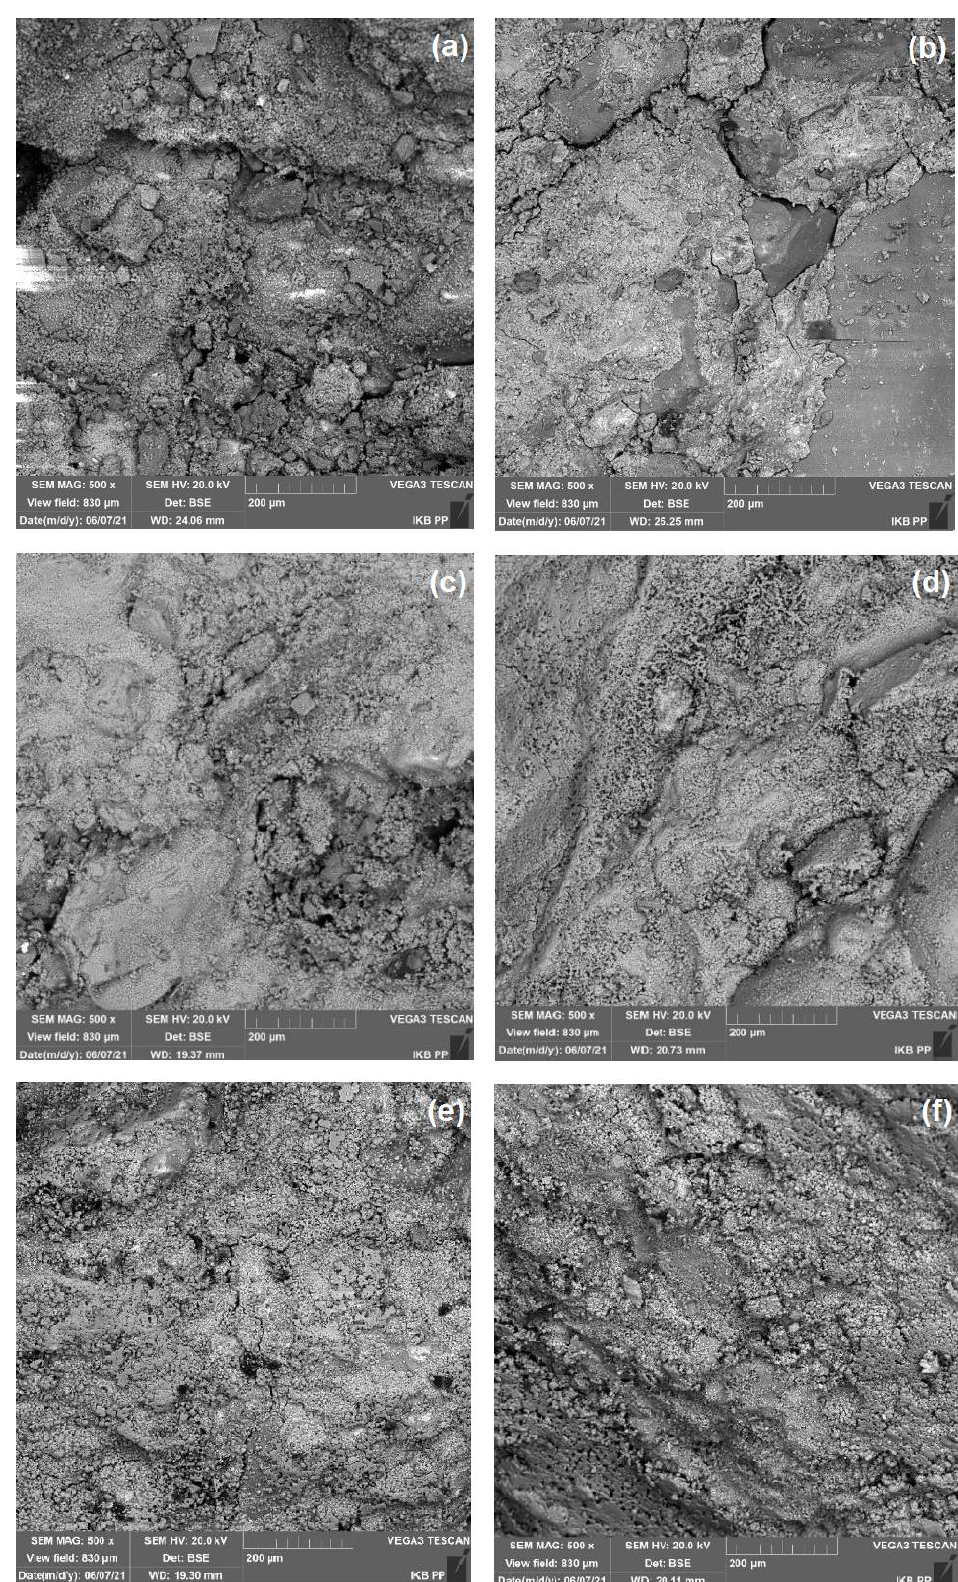
Figure 6. SEM images of clean cement mortar ( a ) and cement composites with ZnO (0.1%) ( b ); CuO (0.5%) ( c ); TiO 2 (1.0%) ( d ); ZnO (0.1%) + CuO (0.5%) ( e ); TiO 2 (1.0%) + CuO (0.5%) ( f ).